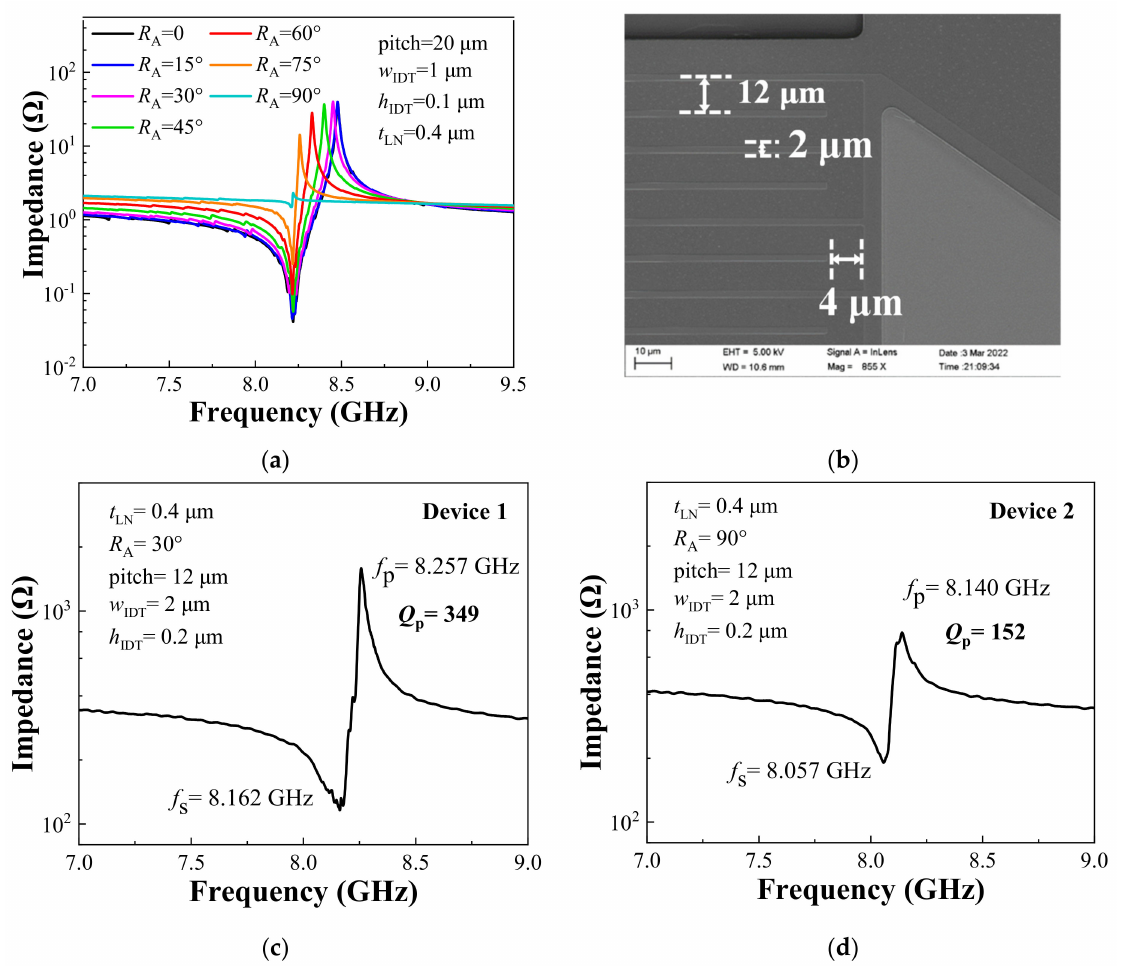
Figure 4. ( a ) Impedance curves of resonator simulation with different IDTs rotation angles; ( b ) SEM image of the fabricated resonators; Measured results of ( c ) device 1 and ( d ) device